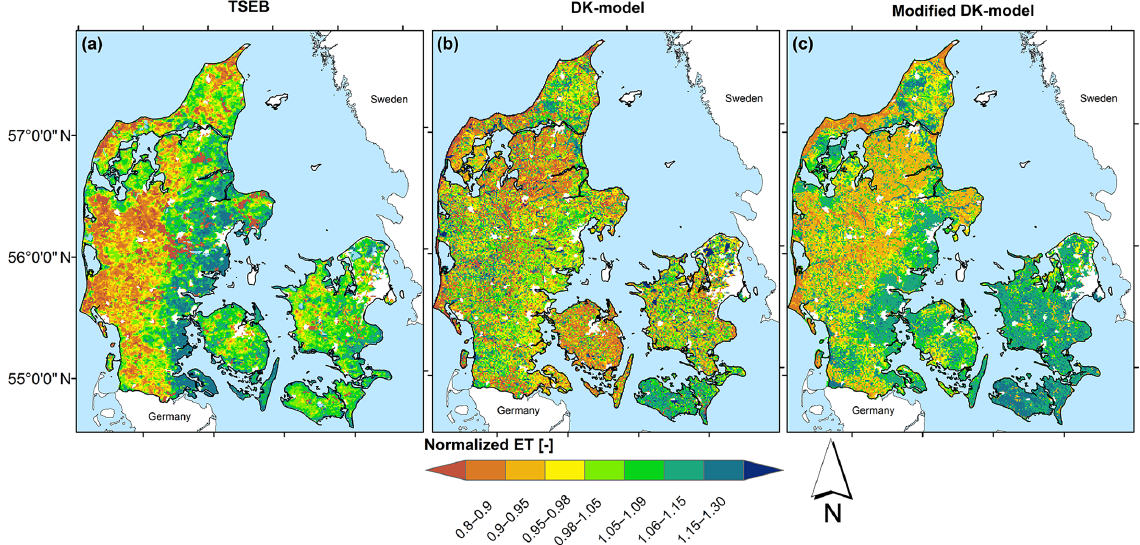
Figure 8. Normalized growing season maps for the TSEB (a) , DK-model (b) and the modified version of the DK-model (c) . Normalization was conducted by dividing the mean map by the mean value of the